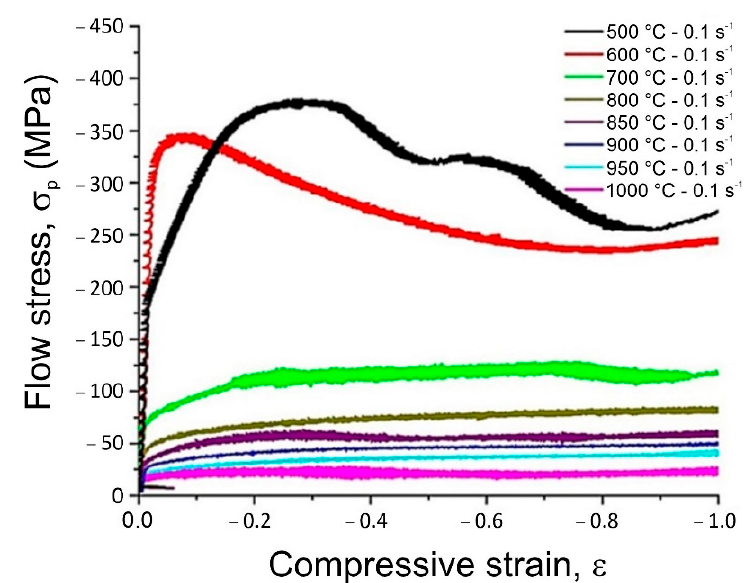
Figure 6. Effect of the strain temperature on the shape of stress–strain curves of the CuNiSi alloy after real deformation: ε = 1, with a constant strain rate equal to 0.1 s − 1.